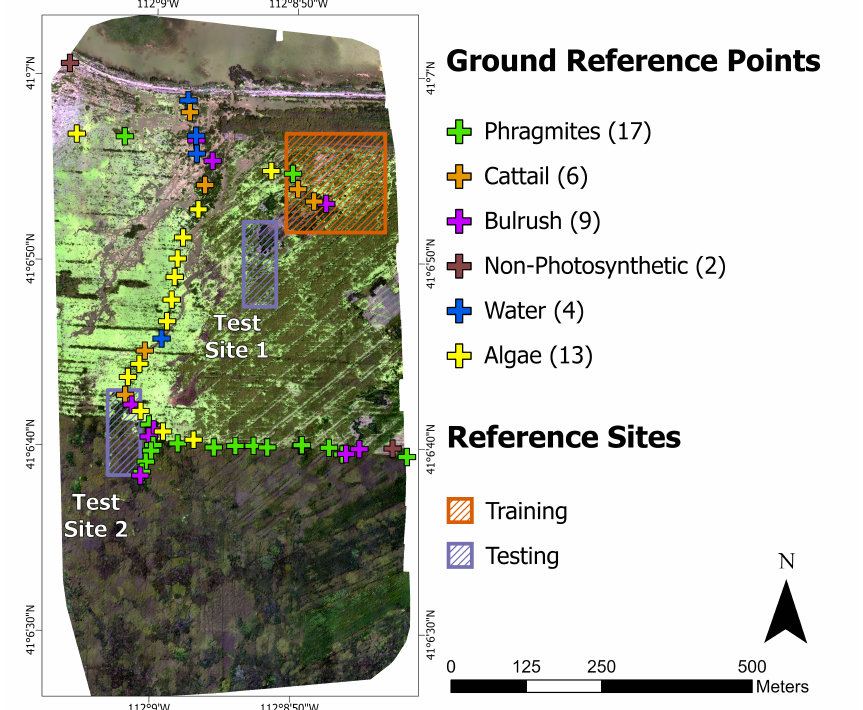
Figure 4. A map of ground reference points and reference sites within the study area. The background image is the 7.6 cm true color composite of UAS imagery acquired in August